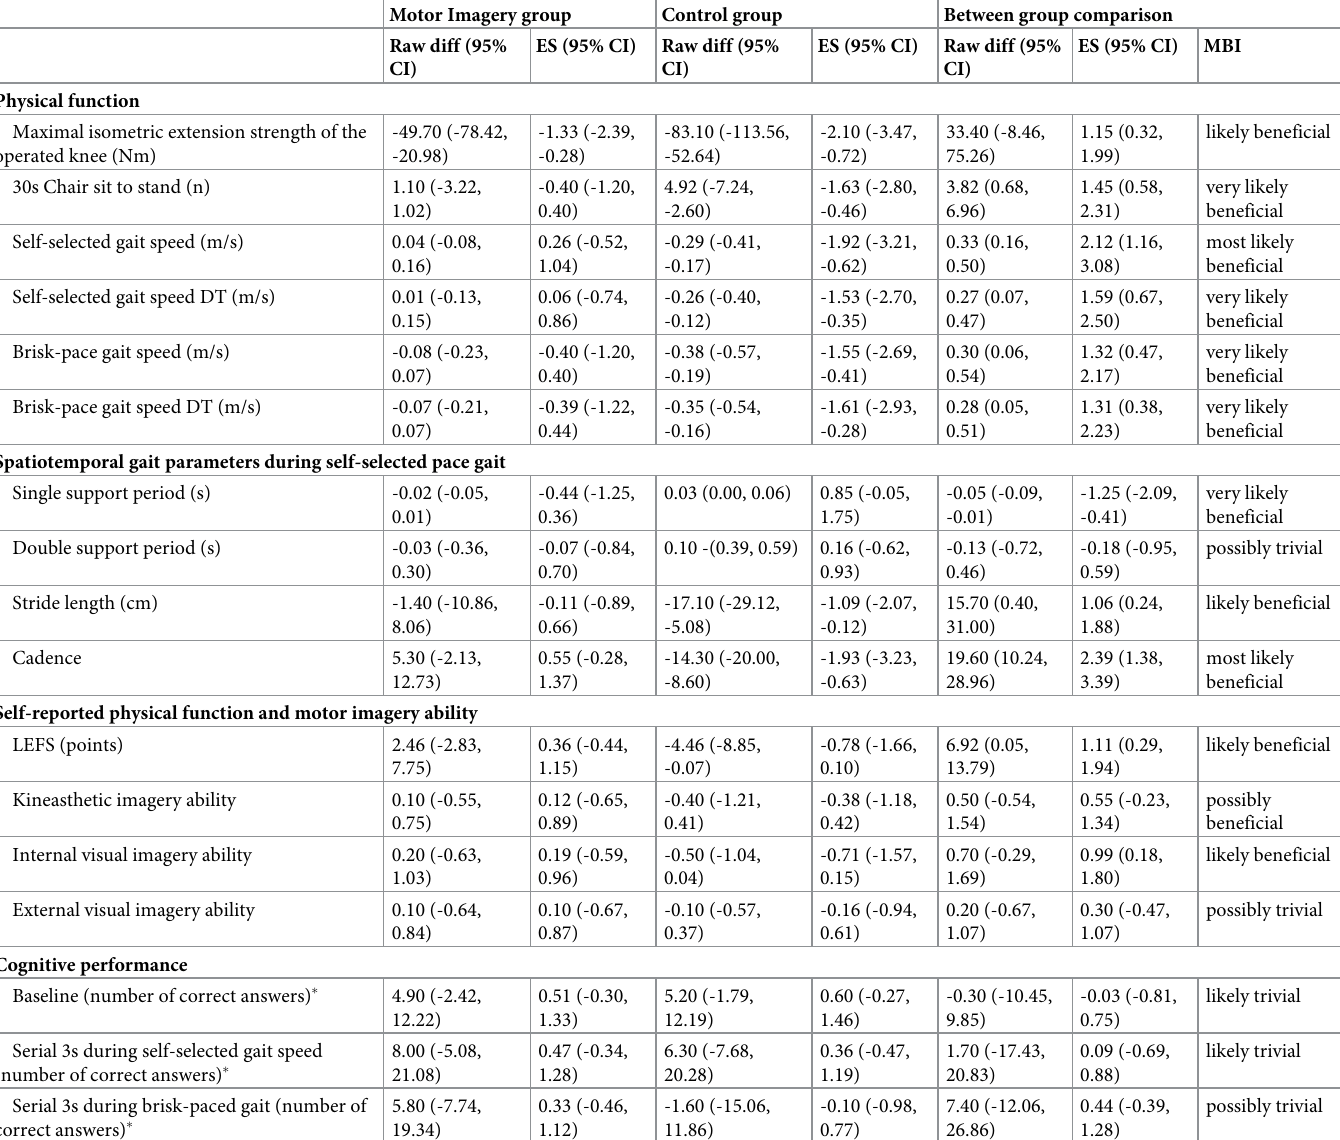
Table 3. Magnitude-based inferences and absolute changes between initial and final measurements in: Motor imagery group, control group, and between groups (per protocol